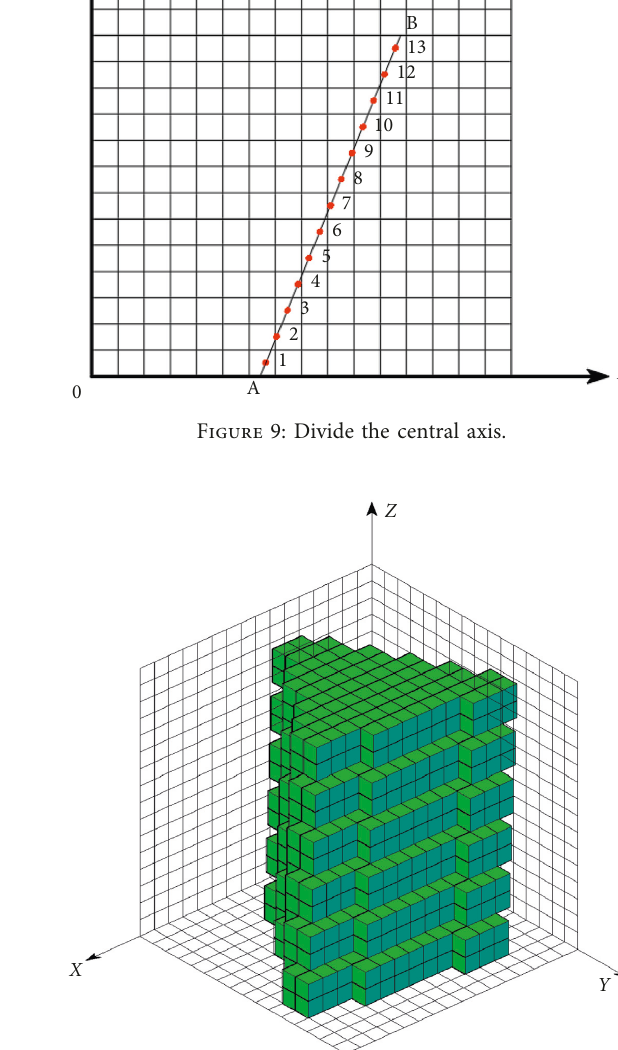
Figure 10: OBST representation for swept